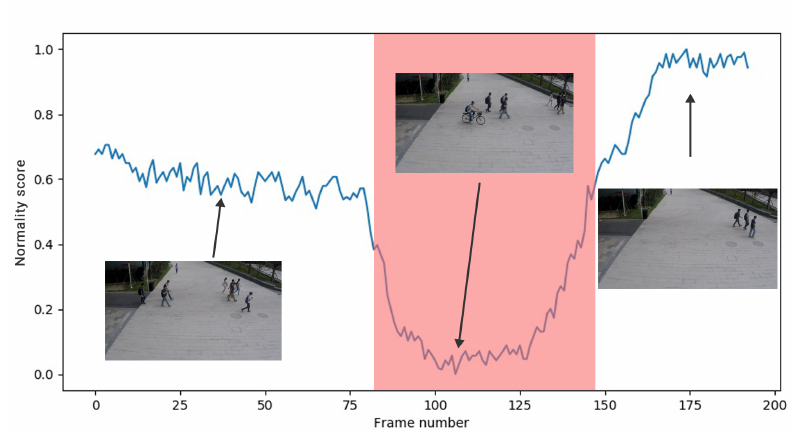
Figure 8. Normality Score of video clips from ShanghaiTech dataset. Regularity score is normalized to [0, 1] and the red areas in the figure represent anomalies.